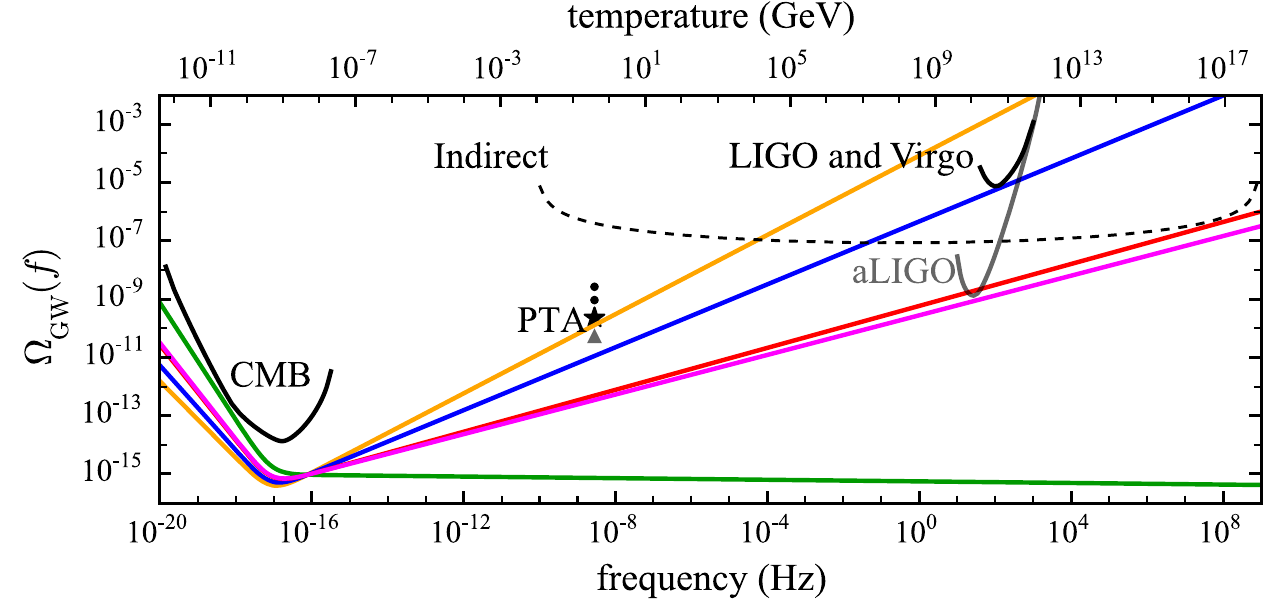
ð f Þ . The black star is the current Parkes Pulsar Timing Array (PPTA) upper limit and all FIG. 1. Experimental constraints on Ω GW black curves and data points are current 95% confidence upper limits. The gray curve and triangle are, respectively, the predicted aLIGO sensitivity and PPTA sensitivity with 5 more years of data. The indirect GW limits are from CMB temperature and polarization power spectra, lensing, BAOs, and BBN. Models predicting a power-law spectrum that intersect with an observational constraint are ruled out at > 95% confidence. We show five predictions for the GW background, each with r ¼ 0 . 11 , and with n t ¼ 0 . 68 (orange curve), n ¼ 0 . 54 (blue curve), n ¼ 0 . 36 (red curve), n ¼ 0 . 34 (magenta curve), and the consistency relation, n t t t corresponding to minimal